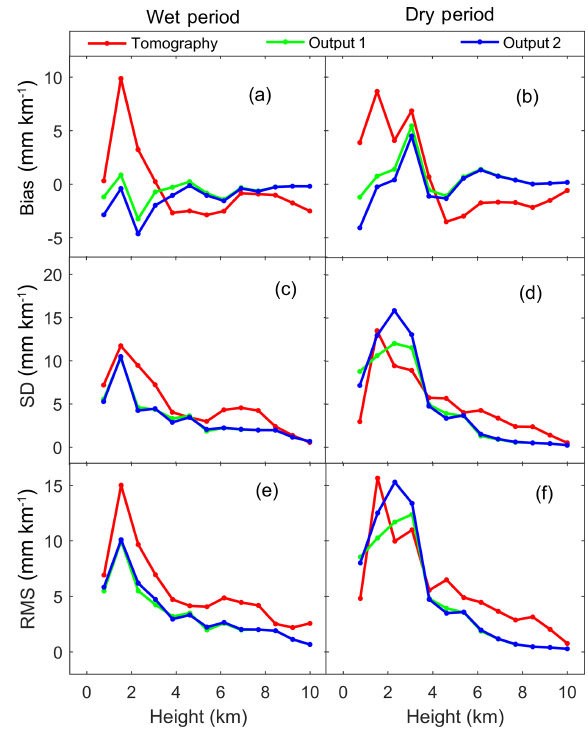
Figure 5. Comparisons among WR derived from Output1, Output2, tomography, and radiosonde in the dry period, 2015.